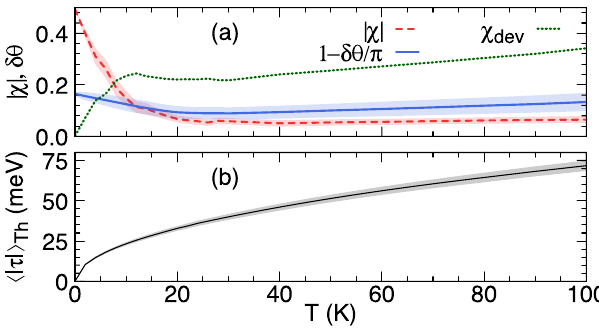
Fig. 6 Effect of ambient temperature on the chirality of the fi nal con fi guration. Variation of ( a ) chirality ( χ in red), relative angle ( δθ in blue), χ dev (green) and ( b ) average thermal torque, 〈 ∣ τ ∣ 〉 Th (root mean square deviation as shaded region), with temperature, for hopping parameter of 0.4 eV. The values are obtained at 8 ps from averaging over 64 con fi gurations over a time period of